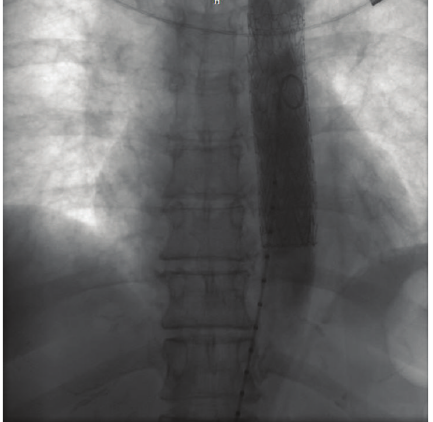
Figure 4: Poststent deployment aortic angiogram demonstrating successful exclusion of the thrombus bulk with a small area of residual thrombus at the inferior